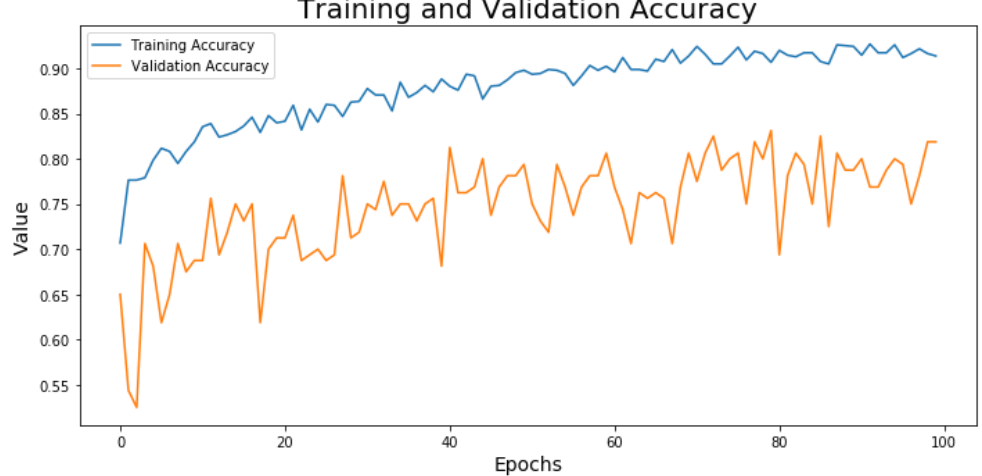
Figure 7. Training and validation accuracy for the proposed reduced model.